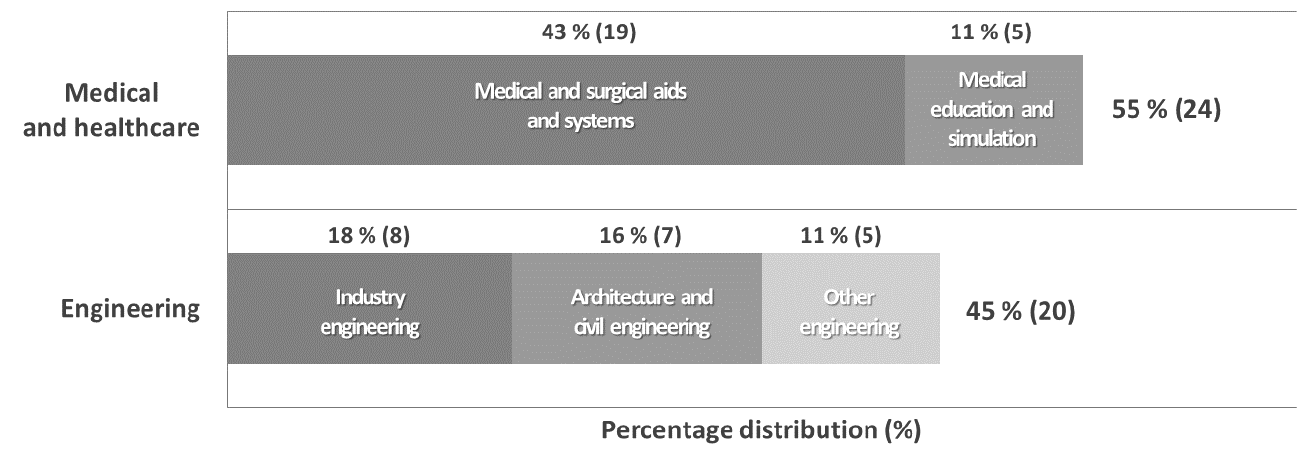
Figure 14. Percentage distribution and number of reviewed studies of HoloLens applications in the medical and healthcare and engineering fields.